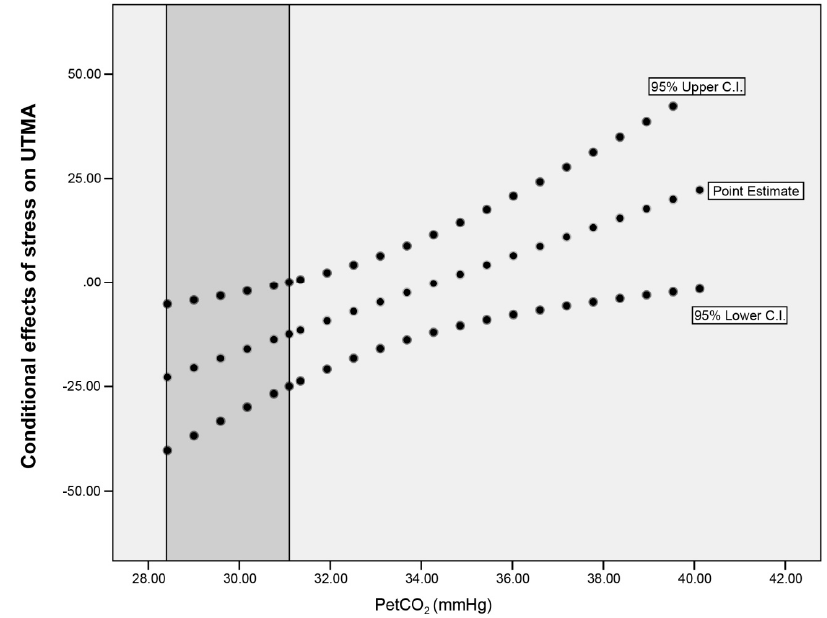
Figure 1. Johnson ‐ Neyman graph showing the range of PetCO 2 values where significant effects of Figure 1. Johnson-Neyman graph showing the range of PetCO 2 values where significant effects of stress on upper trapezius muscle activity occurred. stress on upper trapezius muscle activity